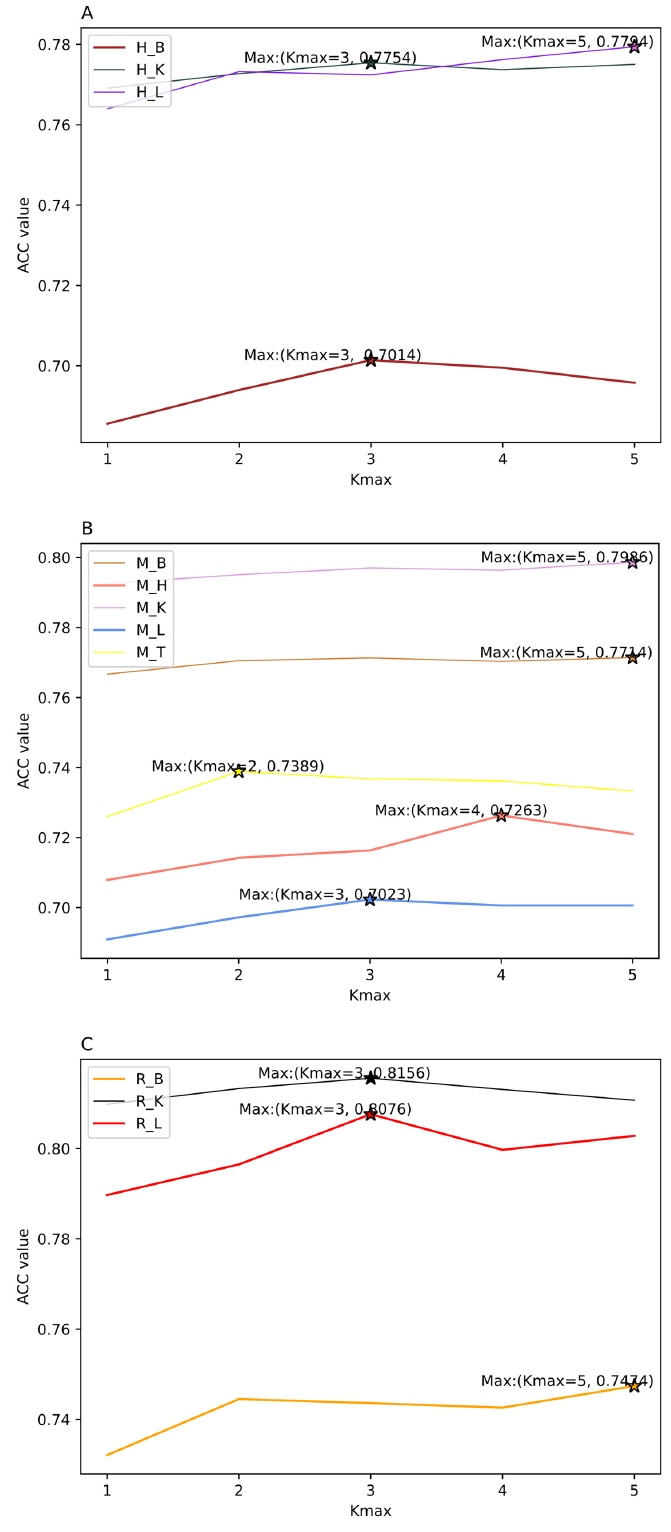
Figure 3. The effect of choosing different K max values in K-spaced Nucleotide Pair Frequencies (KSNPFs) on eleven datasets. Figure ( A ) shows the accuracy (ACC) values for different K max values on H_B, H_K, and H_L datasets. Figure ( B ) shows the ACC values for different K max values on M_B, M_H, M_K, M_L, and M_T datasets. Figure ( C ) shows the ACC values for different K max values on R_B, R_K, and R_L